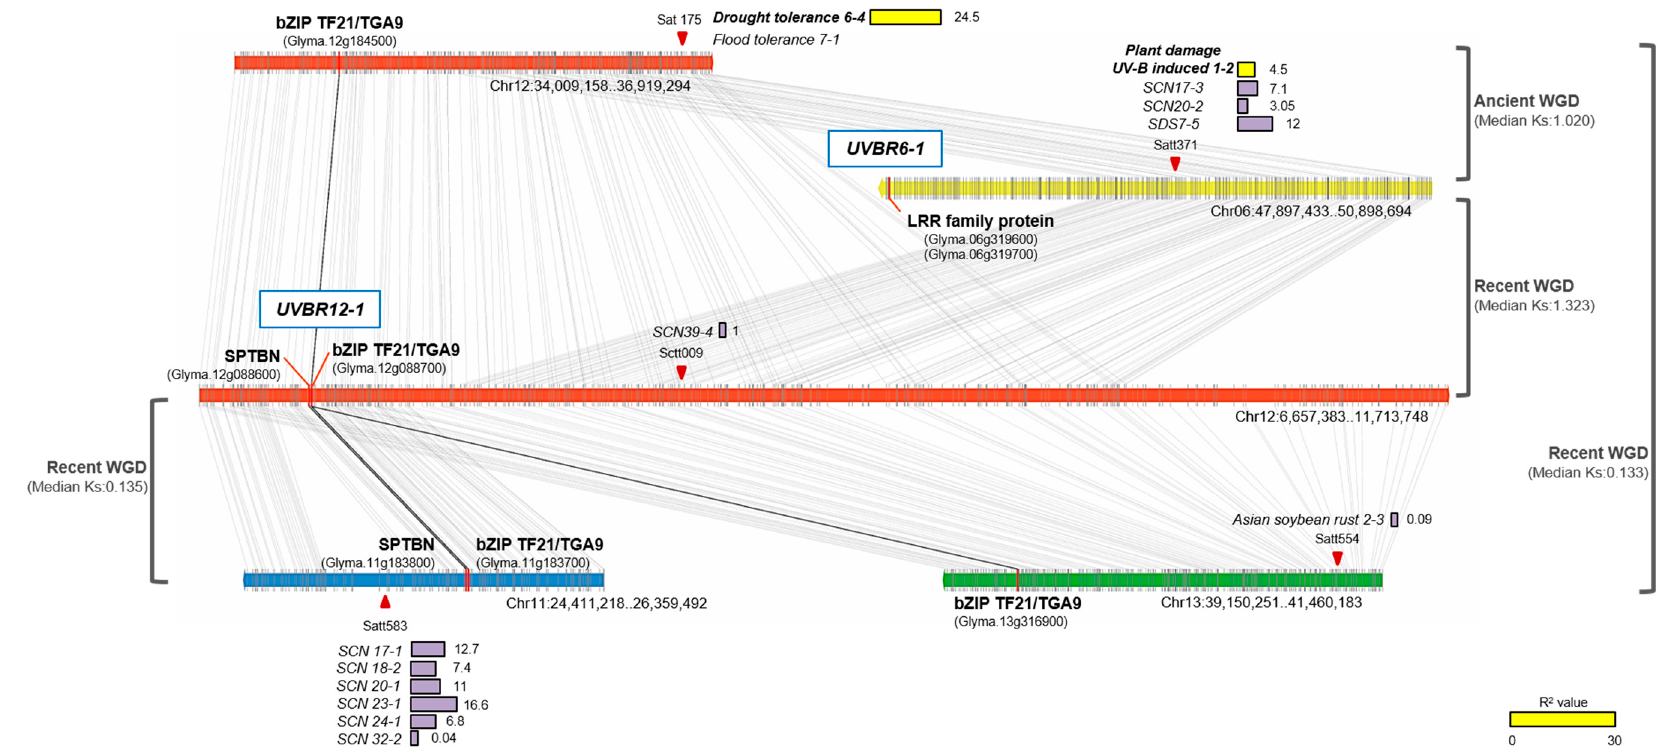
Figure 5. Syntenic conservation of two genomic regions of UVBR12-1 and UVBR6-1 and comparisons with other known stress-related QTL regions. The genomic region with UVBR12-1 (Chr12:6,657,383 ... 11,713,748) had a duplicated block on the same Chr 12 (Chr12:34,009,158...36,919,294) and three additional homeologous regions on Chr 6, 11, and 13. Whole genome duplication (WGD) events producing each pair of syntenic blocks are defined as recent or ancient based on median Ks values. Among two genes in UVBR12-1 , bZIP TF21 / TGA9 was retained in all duplicated regions but SPTBN was only retained in the homeologous block on Chr 11 and was lost in the other blocks. Yellow and purple bars indicate phenotypic R2 values of known QTLs related to abiotic and biotic stress, respectively. SPTBN, spectra beta chain, brain; bZIP TF21 / TGA9, bZIP transcription factor 21 / TGACG motif-binding 9; SCN, Reaction to Heterodera glycines ; SDS, Reaction to Fusarium solani f. sp. glycines infection.